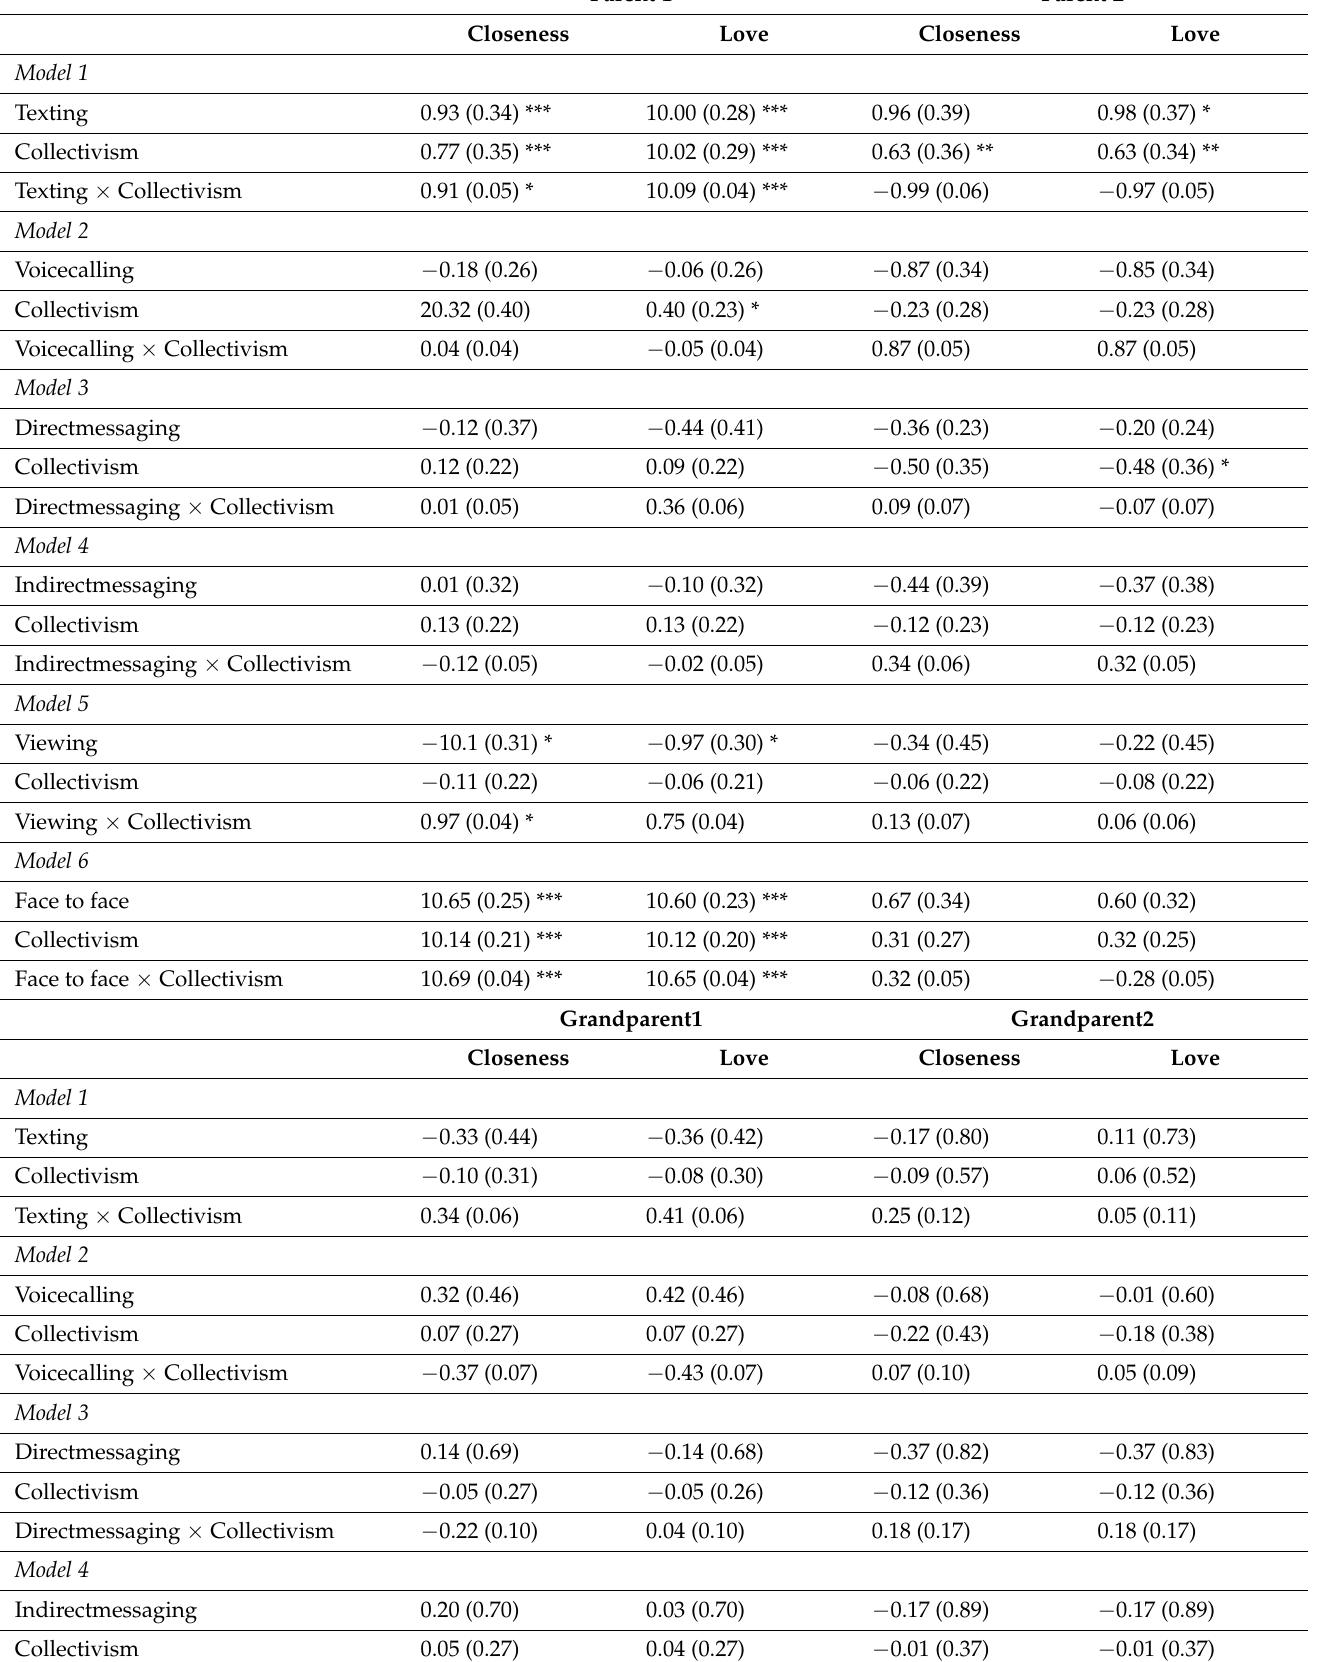
Table 3. Moderation analyses of collectivism for multimodality, FtF and family